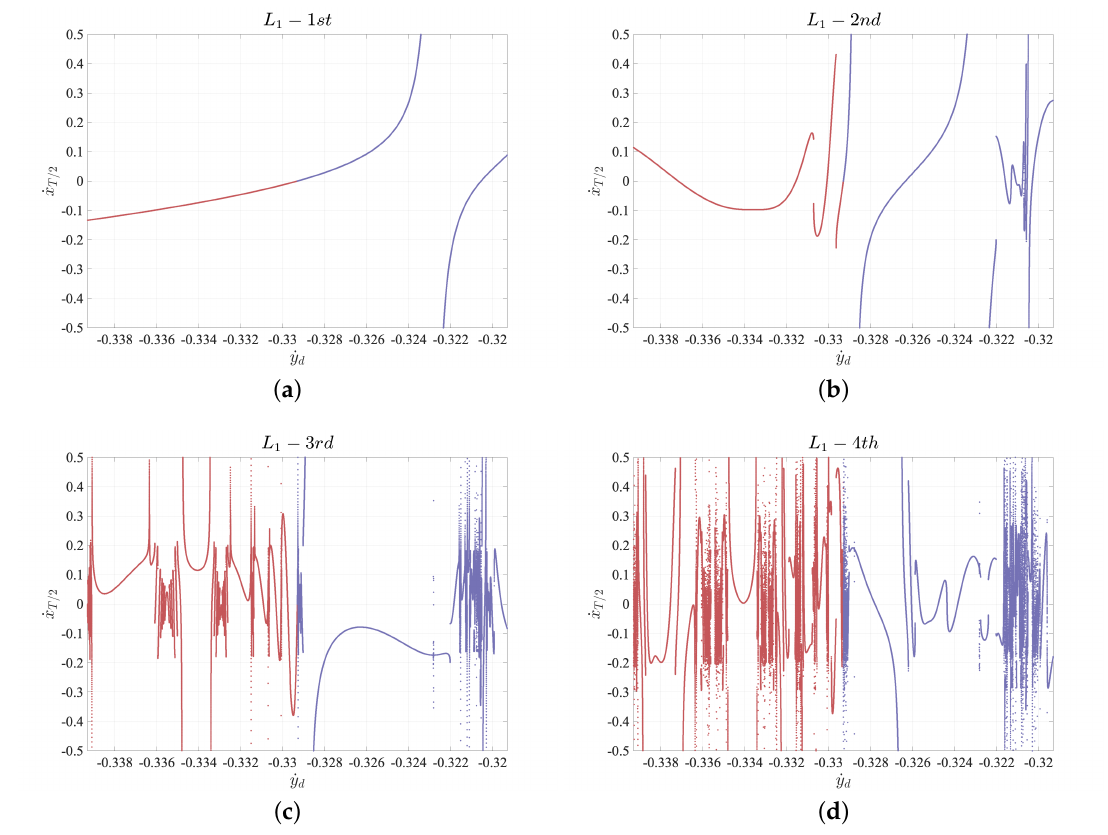
Figure 13. Curves of the velocity along the x -direction when the trajectory intersects with the x -axis for the first ( a ), second ( b ), third ( c ), and fourth ( d ) time. The abscissa is the initial velocity along the y -axis. The reference orbit is a planar Lyapunov orbit around the L 1 point with a Jacobi constant of C = 3.00391283019118. The purple dots indicate a positive ∆ v and the red points indicate a negative ∆ v